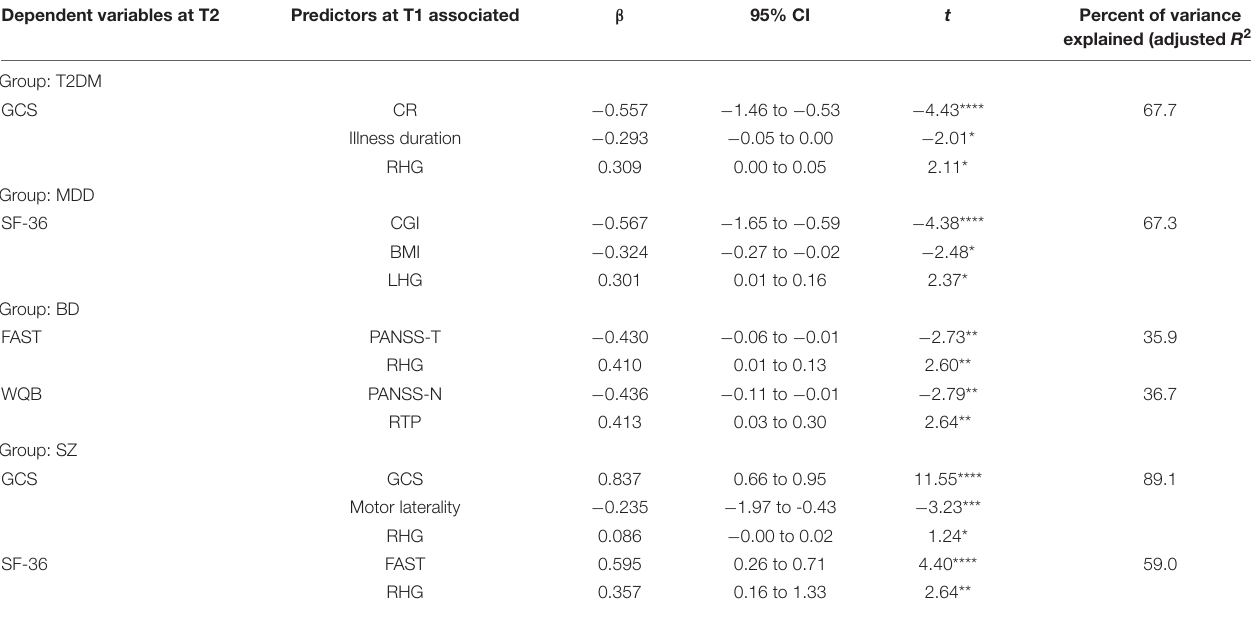
TABLE 3 | Predictive